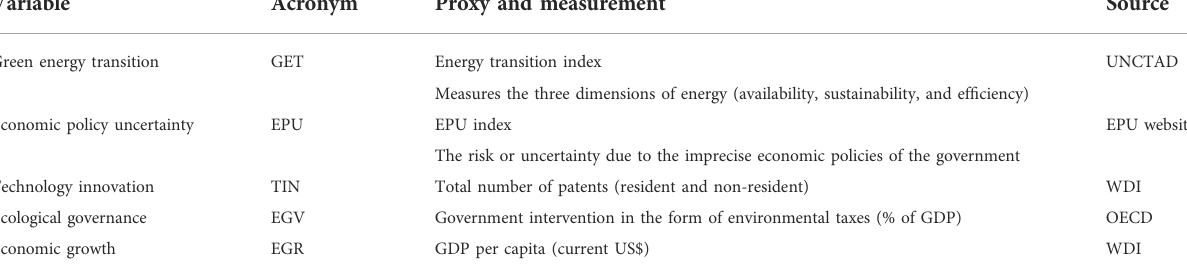
TABLE 1 Variable